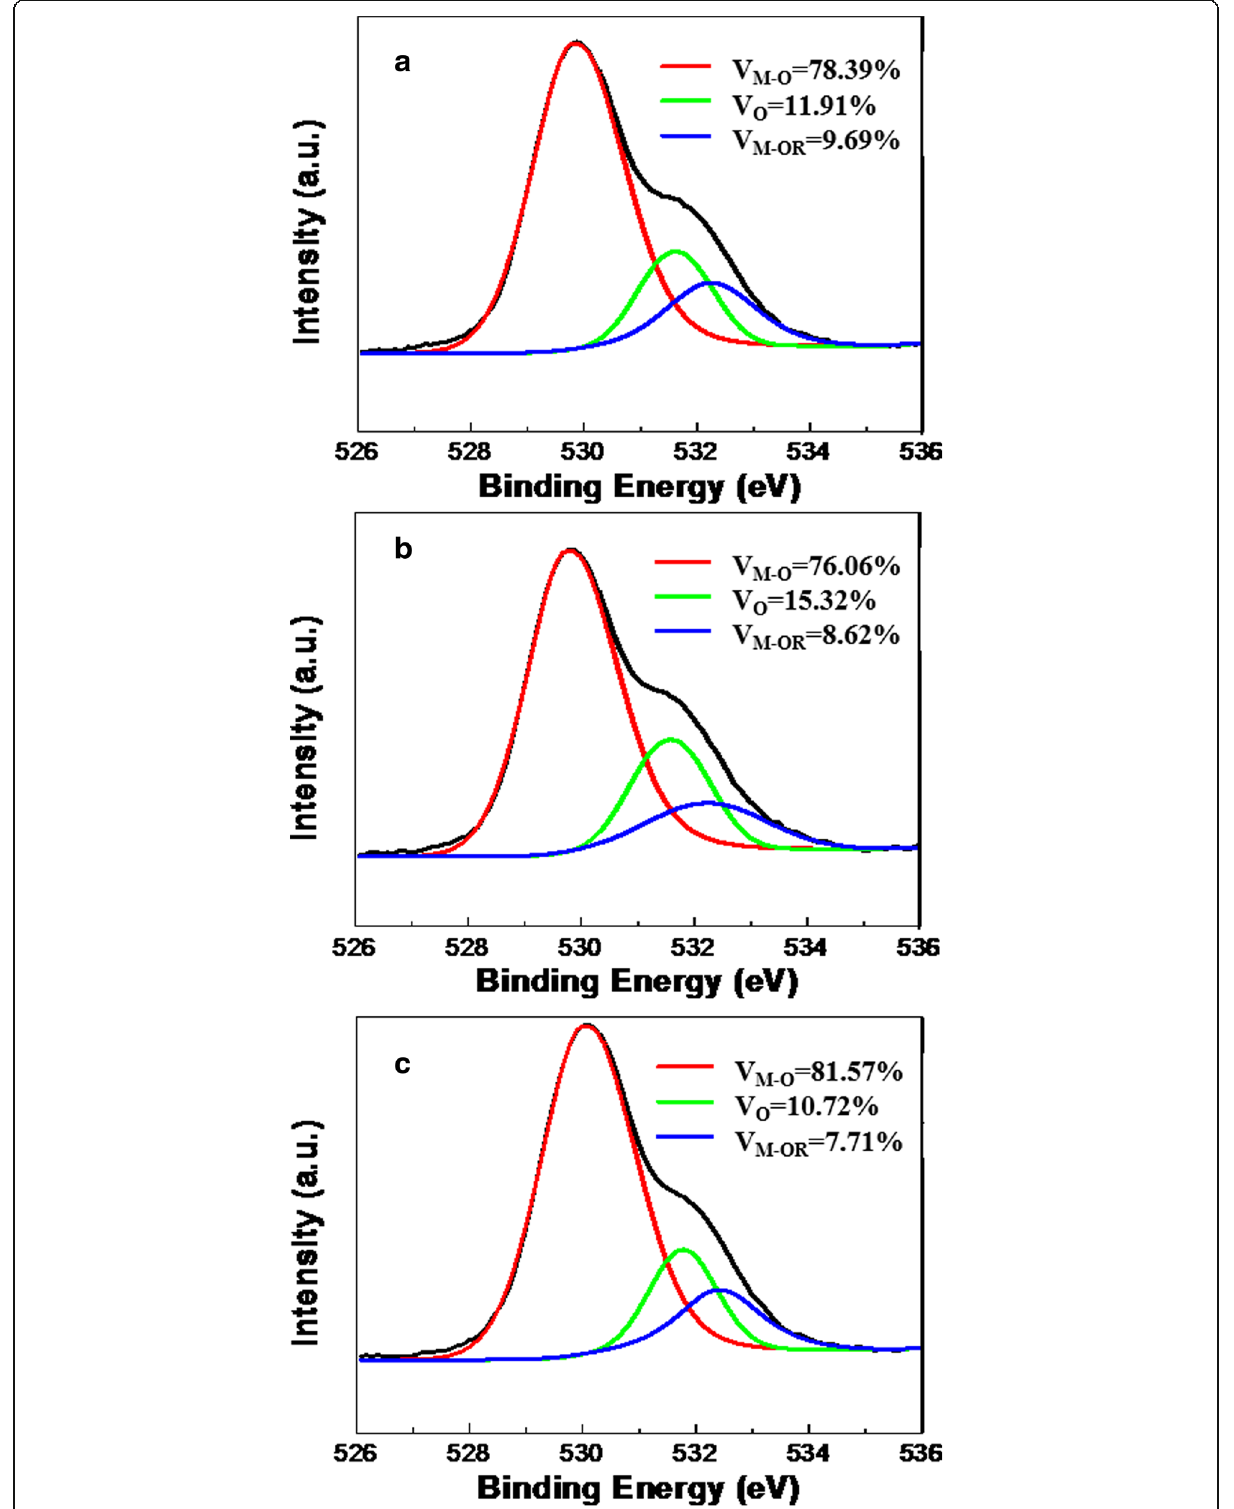
Fig. 2 O1s spectrum of a SC, b DP1-layer, and c DP2-layer ZrO 2